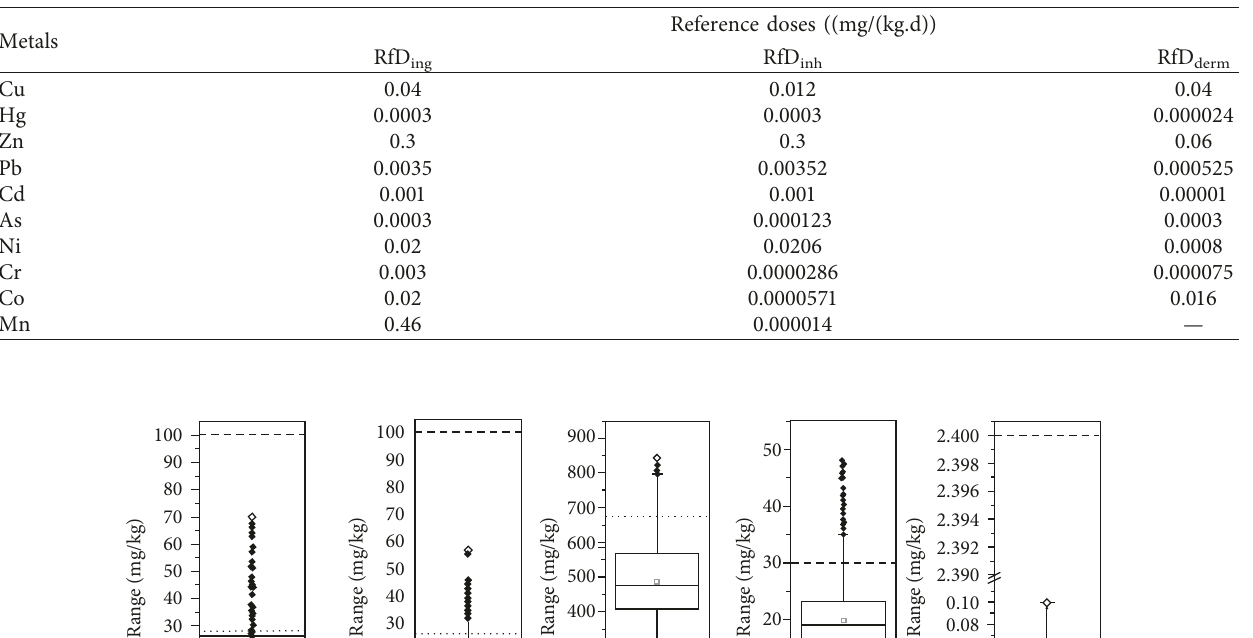
Table 1: Reference doses for the three routes of exposure.